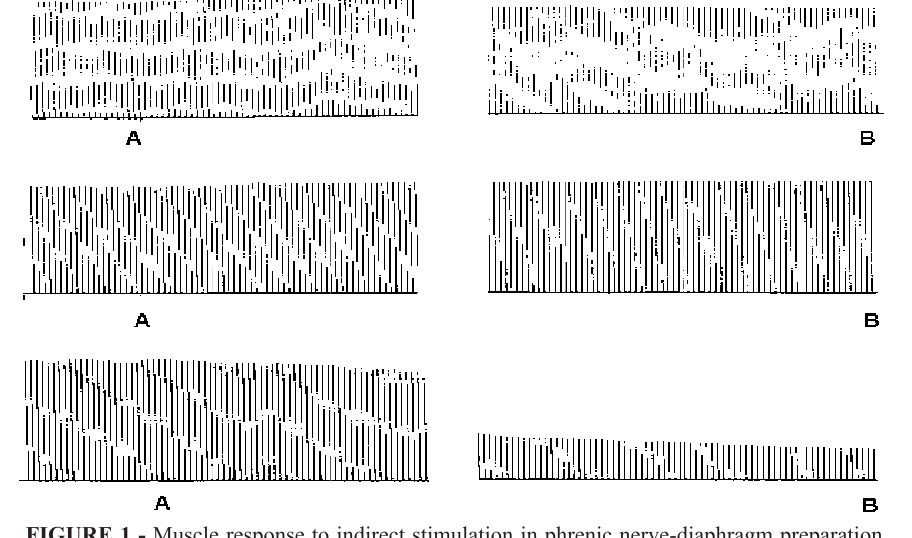
FIGURE 1 - Muscle response to indirect stimulation in phrenic nerve-diaphragm preparation. Effects of lidocaine - 20 µg/mL (upper tracing), of racemic bupivacaine - 5.0 µg/mL (middle tracing), of rocuronium - 4.0 µg/mL (lower tracing) in neuromuscular transmission. A: addition of the drug through the preparation; B: 60 minutes after the